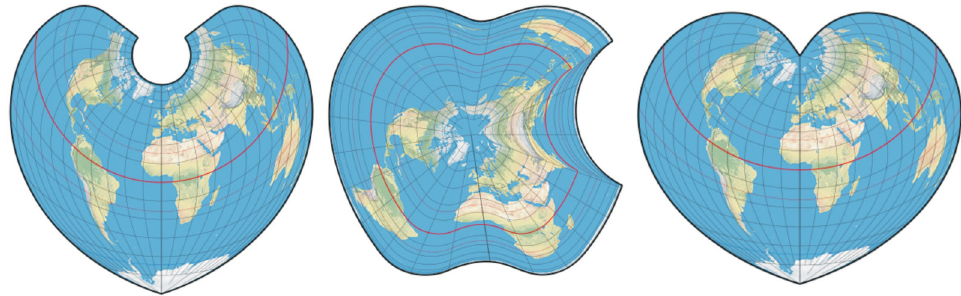
Fig. 24. Map projections for the decorative purposes compiled by D. Strebe